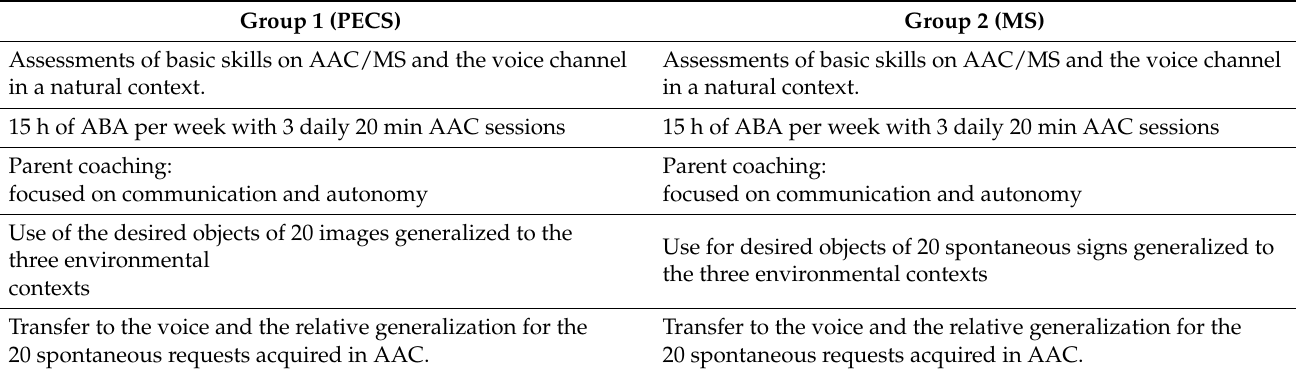
Table 1. Description of training and